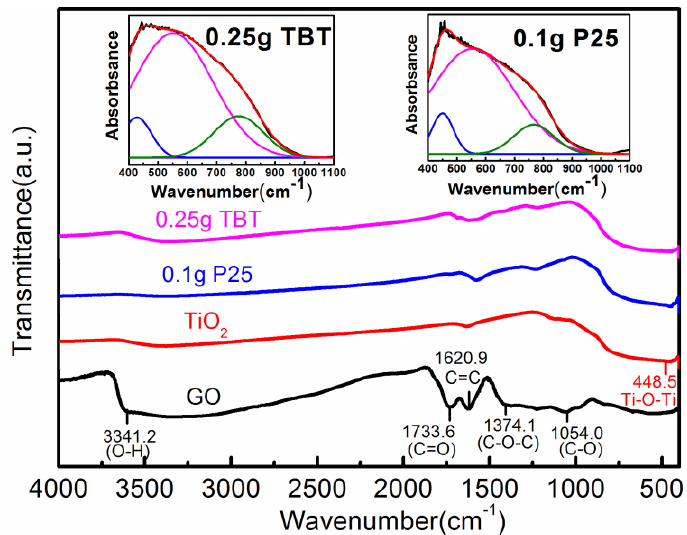
Figure 4. Fourier-transform infrared (FTIR) spectra of GO, TiO2, 0.25 g TBT sample, and 0.1 g P25 sample. The inset shows the deconvolution results of the partial spectra of 0.25 g TBT and 0.1 g P25.